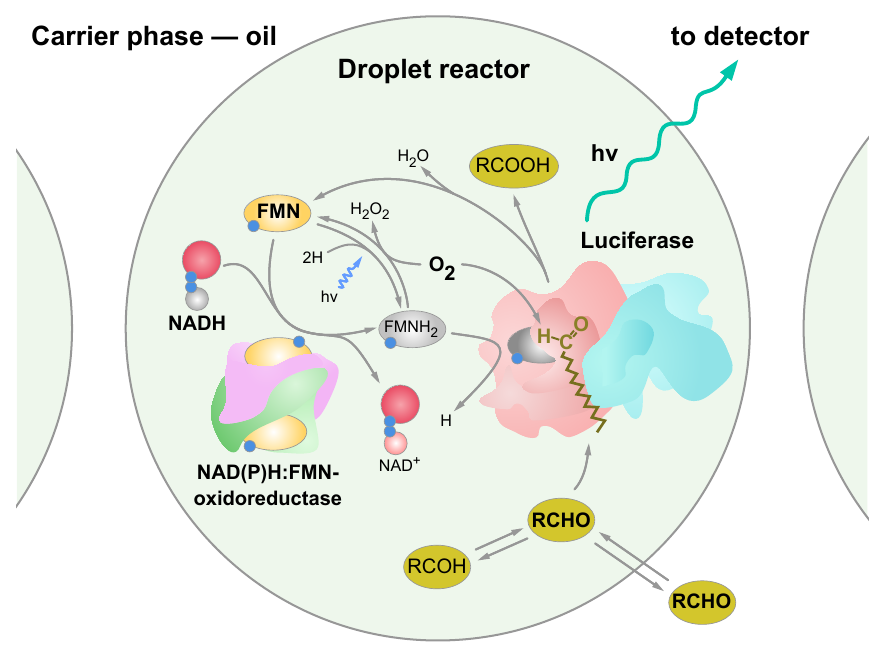
Figure 1. The schematic representation of a droplet reactor with the encapsulated chemoenzy- matic system. The multienzyme part of the system consisted of luciferase and NAD(P)H:FMN– oxidoreductase, as well as substrates: flavin mononucleotide (FMN), reduced nicotinamide adenine dinucleotide (NADH) and